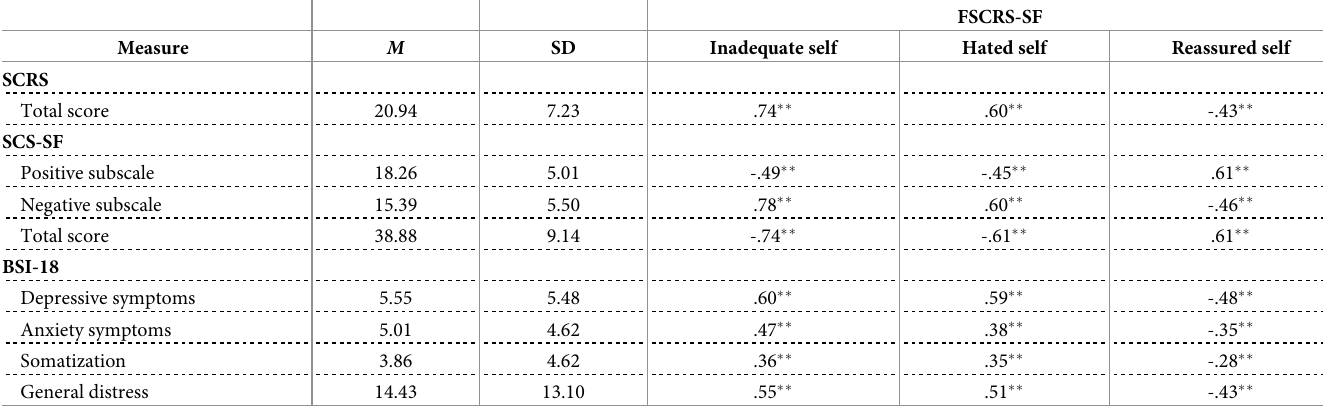
Table 4. Convergent and divergent validity of the FSCRS-SF